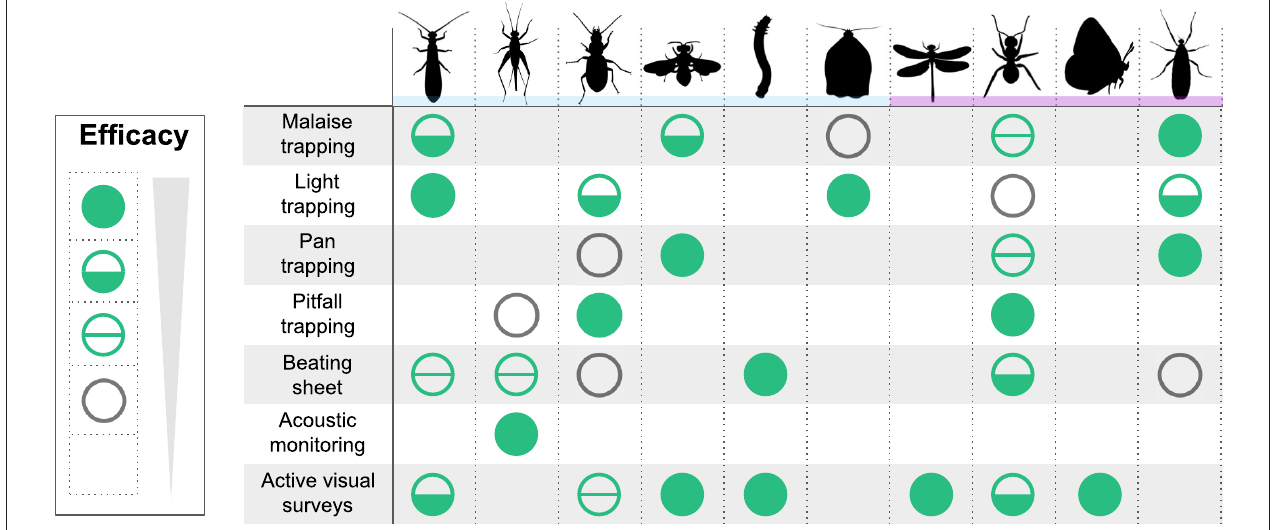
methods may need to be modified from those discussed here or may not be